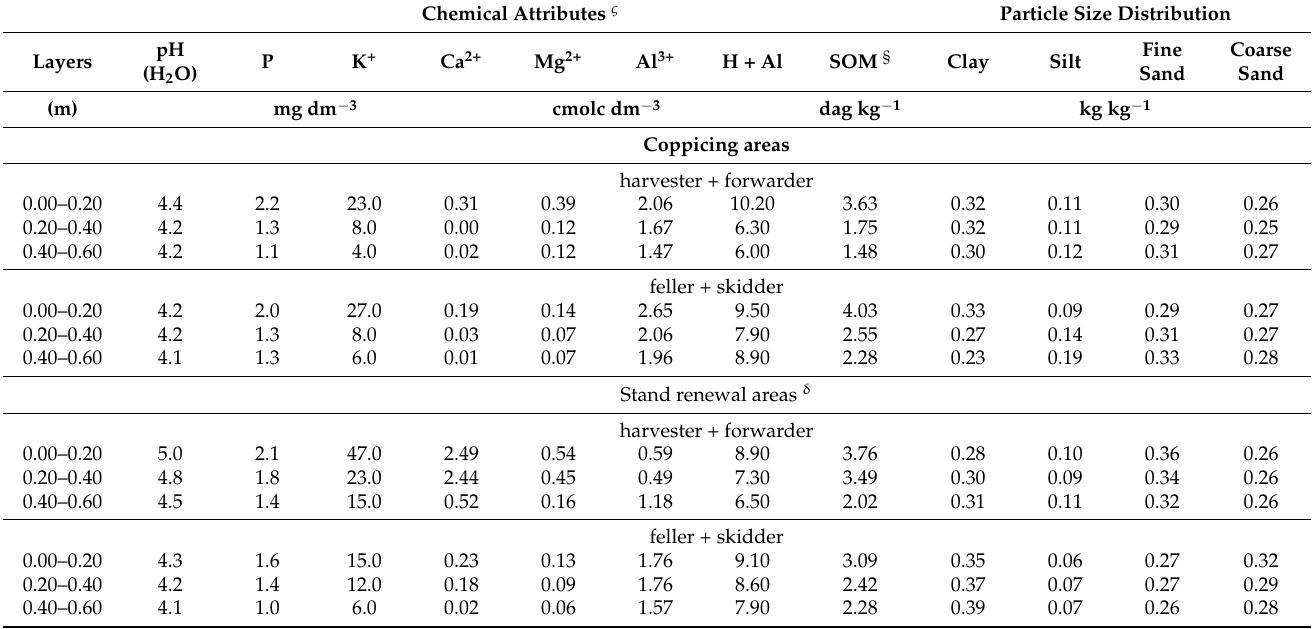
Table 1. Soil chemical characterization and particle-size distribution at the 0–0.20, 0.20–0.40 and 0.40–0.60 m layers, in eucalypt cultivation areas under coppicing and stand renewal with different straw levels (100, 50 and 0%), both harvested by harvester + forwarder (HF) and feller + skidder (FS)